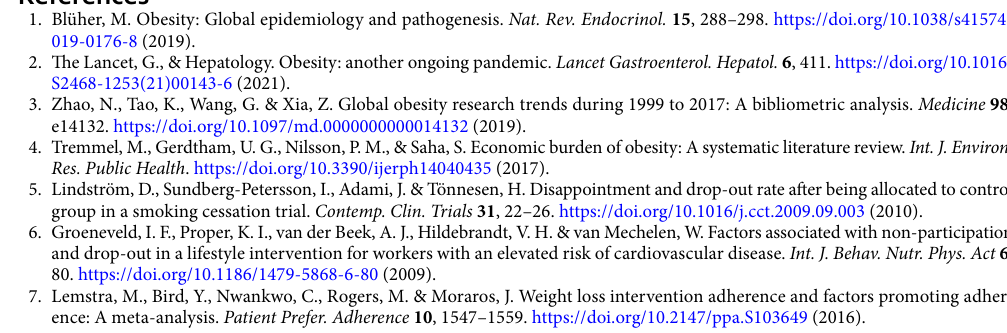
All data generated or analysed during this study are included in this published article (Appendix 2–4).